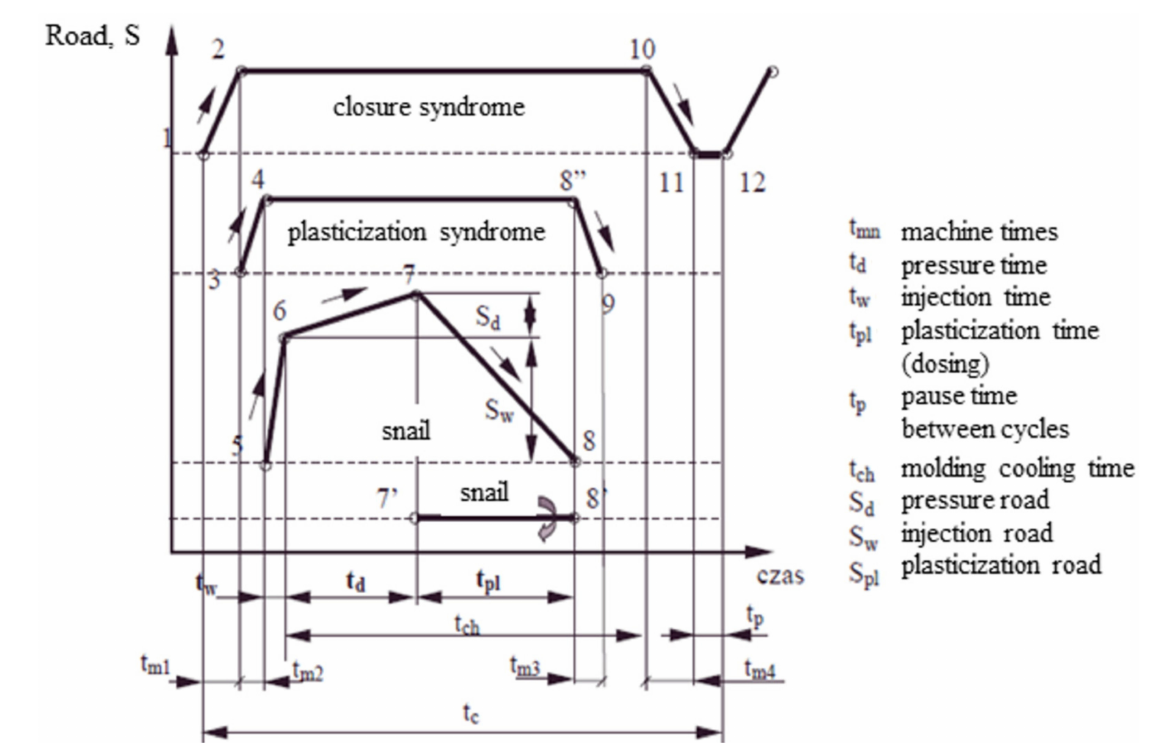
Figure 2. Technological times diagram. Number 1–12 stagest of cycle.